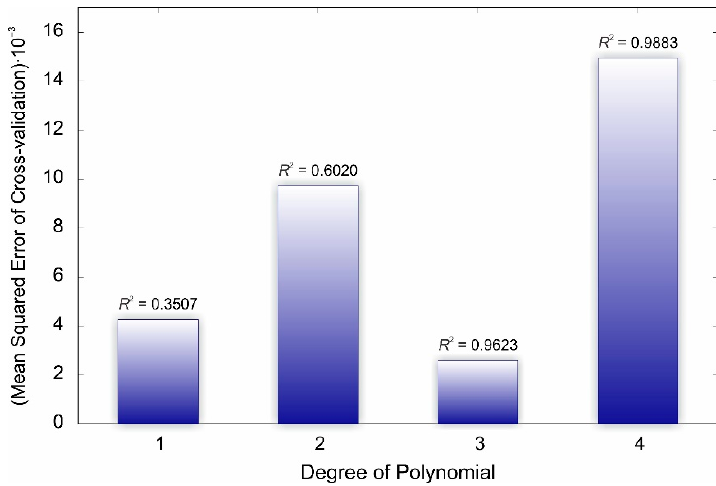
Figure 8. Mean squared error of model prediction obtained by leave-one-out cross validation on the set of the first principal component of biological activity in dependence on the first principal component of potential energy surfaces. ( R 2 values for each model are placed above the bars.)